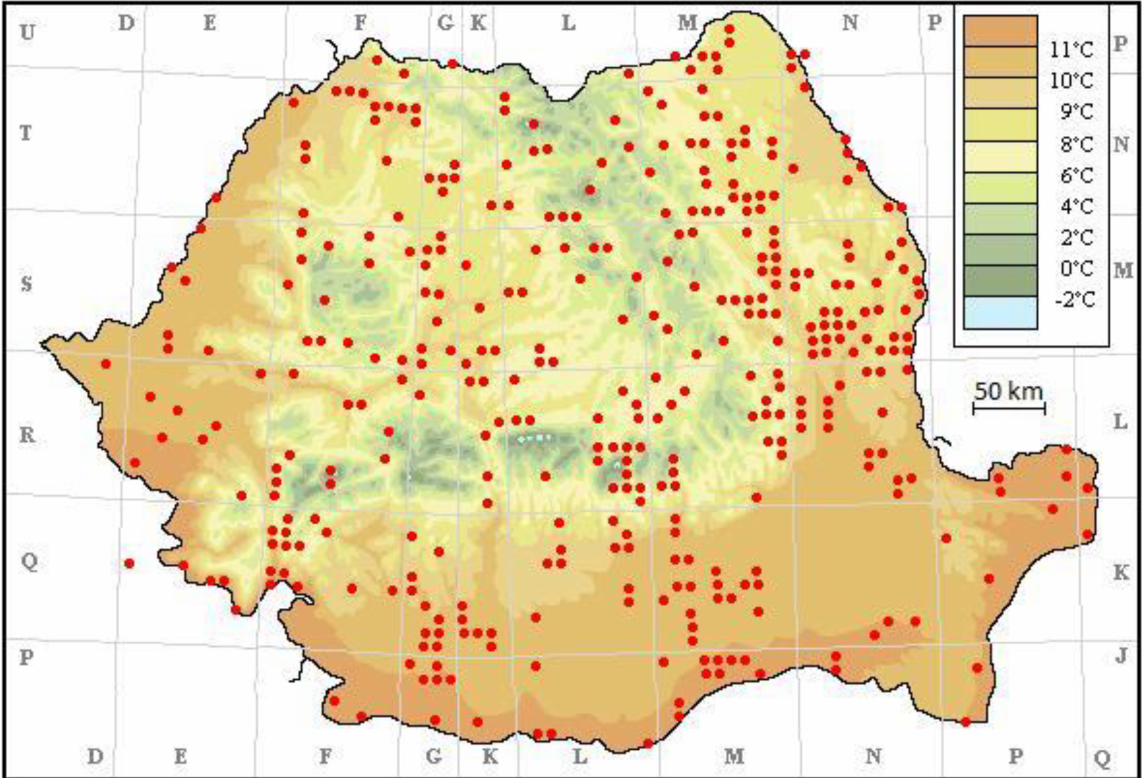
Figure 5. Distribution of Figure 3. Distribution of Salix alba communities. Salix purpurea